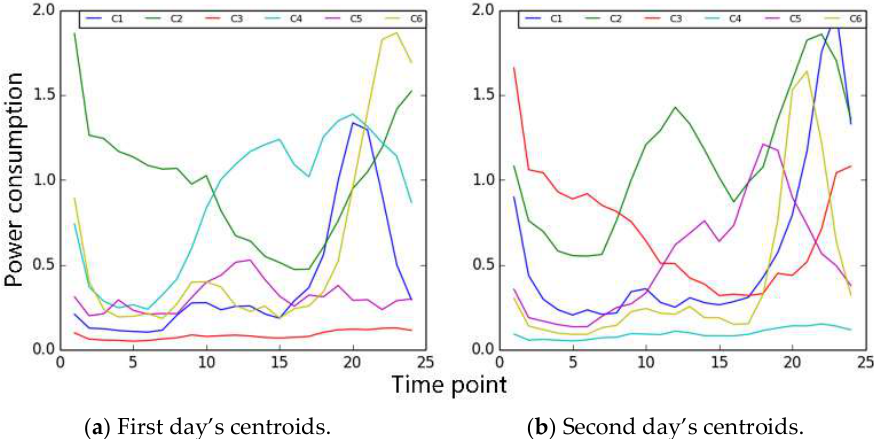
Figure 5. Two days’ centroids of K-means.